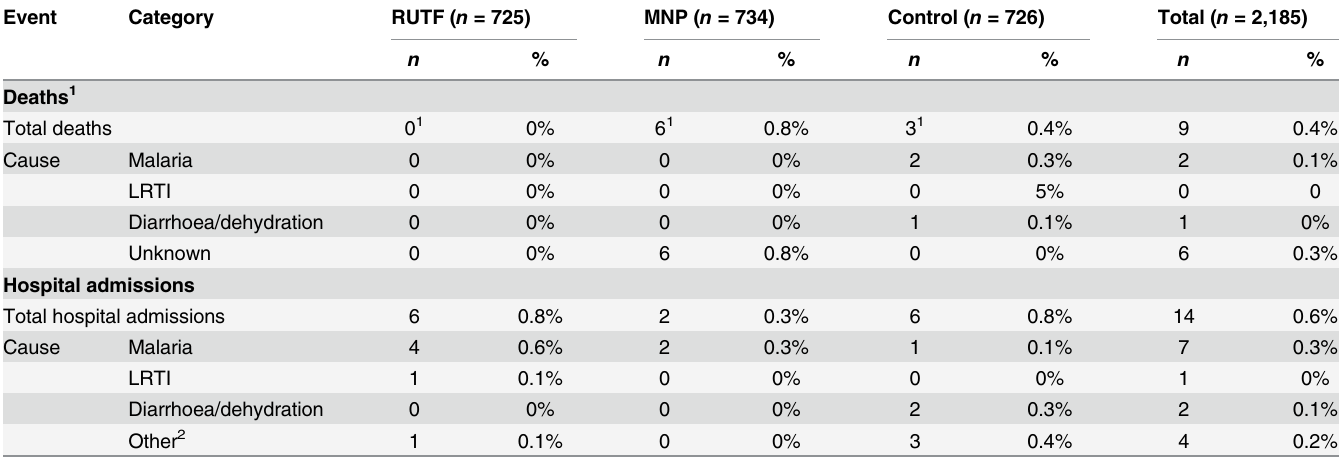
Table 7. Overall mortality and hospital admission by intervention group